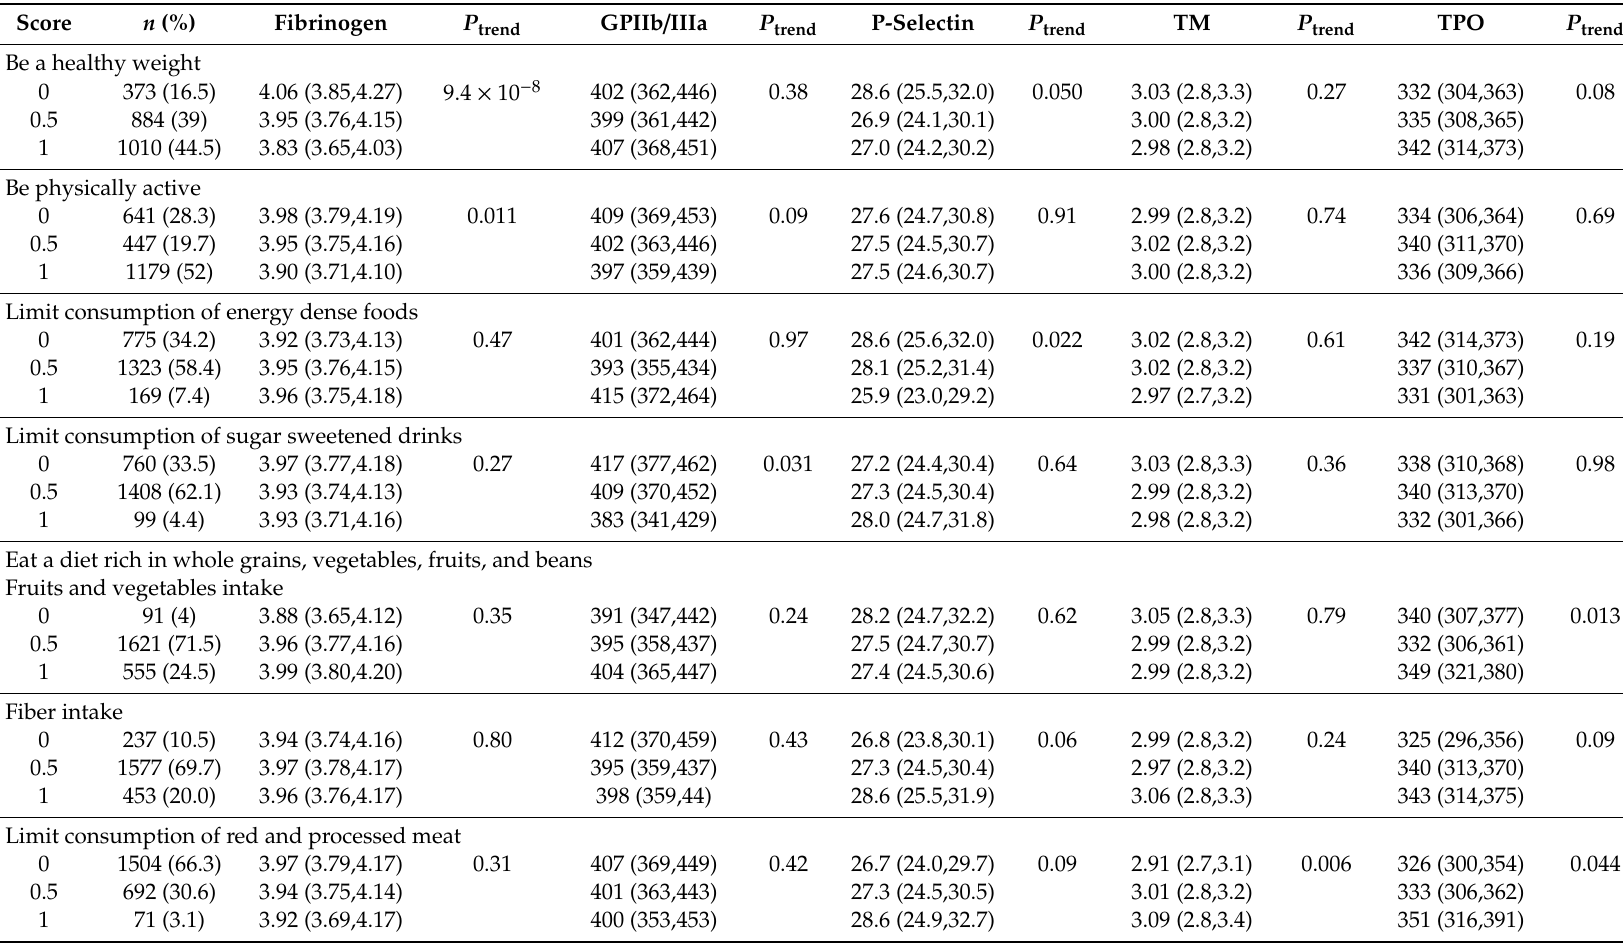
Table 4. Geometric means (95% confidence intervals) of biomarker levels across individual components of the WCRF / AICR recommendations within the EPIC-Heidelberg subcohort ( n =